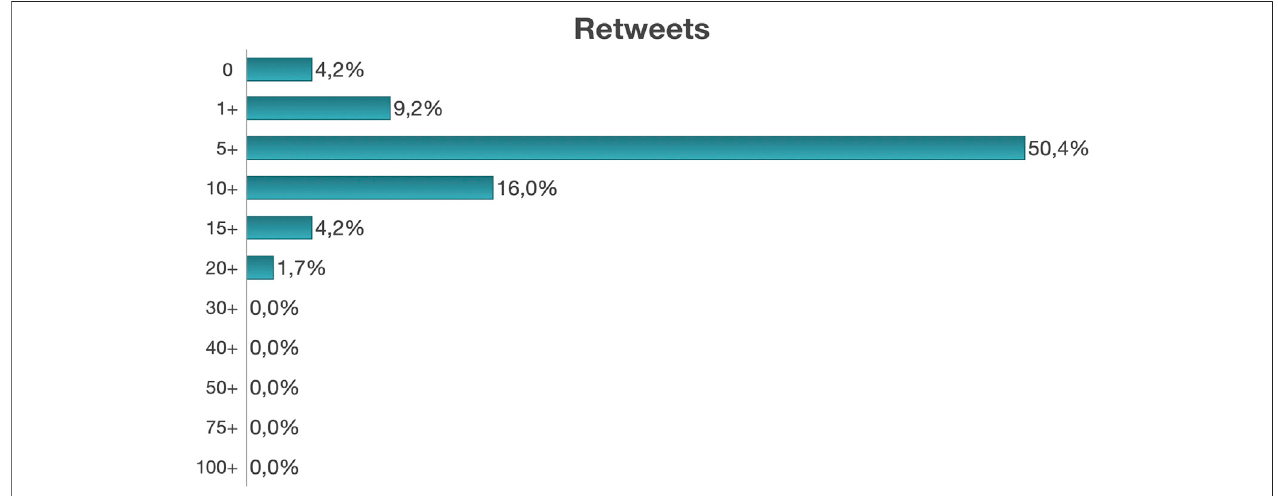
FIGURE 5 | Volume of Retweets of the Congo Check posts.